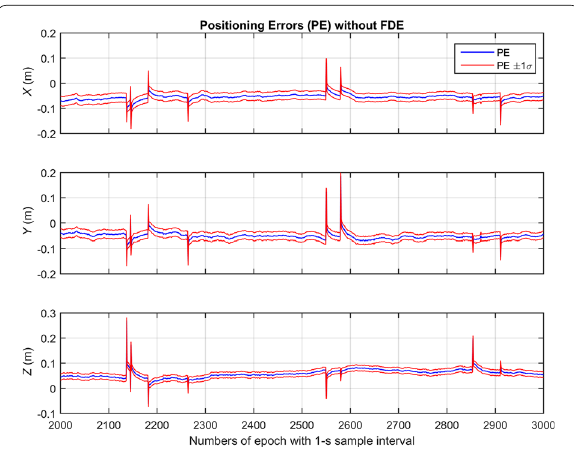
Fig. 2 PPP positioning errors (after convergence) in the case of faulty measurements, with no FDE applied. Note that faults may cause positioning errors larger than the shown 0.2 m maximum